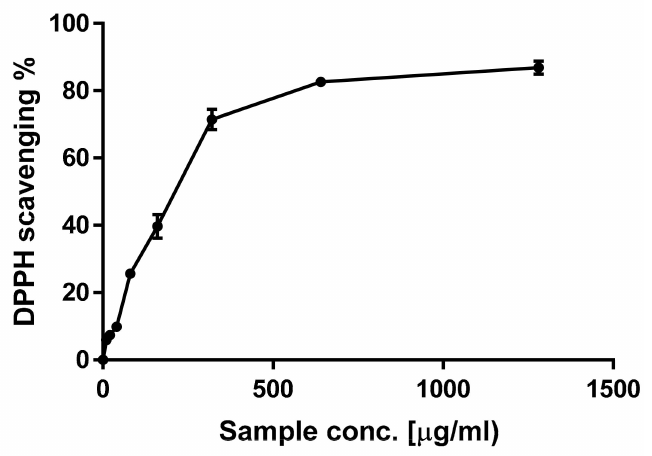
Figure 2. The scavenging rate (%) of 2,2-diphenyl- 1-picrylhydrazyl (DPPH) by C. annua crude extract. All of the values in the figure are expressed as means (%) and SD of triplicated experiments.